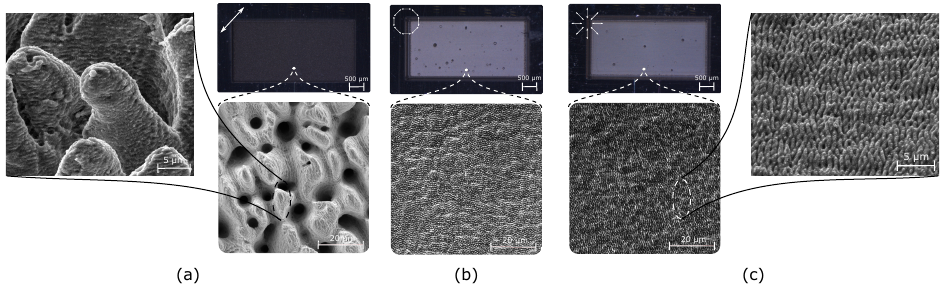
Figure 5. Optic microscope (top) and zoomed SEM micrographs (bottom) of engraved stainless-steel rectangles at 1 m/s scan speed at 51.3 µJ and 100 kHz for: linear Gaussian ( a ), and CV with azimuthal ( b ) and radial ( c ) polarizations.